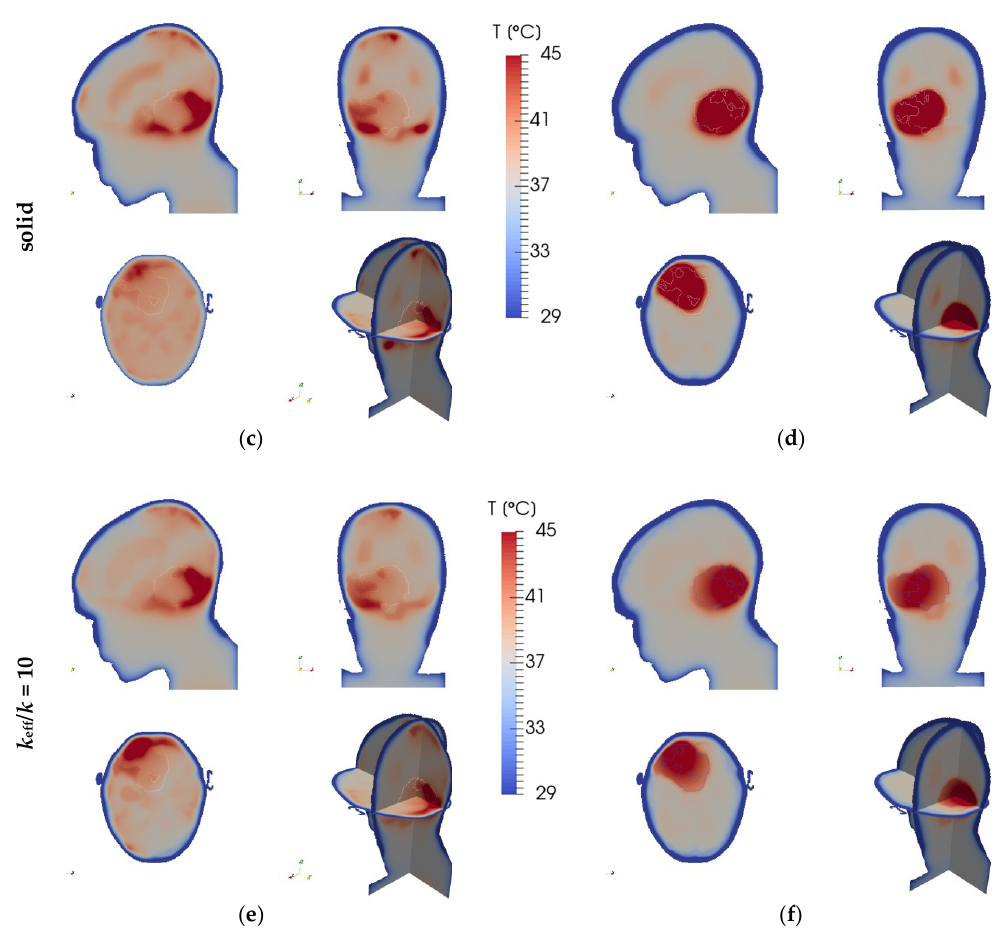
Figure 3. Temperature distributions for ( a,c,e ) the pre-operative and ( b , d,f ) post-operative cases, as predicted by ( a,b ) the fluid model, ( c,d ) the solid model, and ( e,f ) the high- k ( k eff / k = 10) model, per case based on the same SAR distribution (Figure 2). The panels show planes through the tumour’s centre of gravity in the left-right (top-left), anterior-posterior (top-right), and cranial-caudal (bottom-left) directions, and a 3D view (bottom-right). The tumour (region) is outlined.